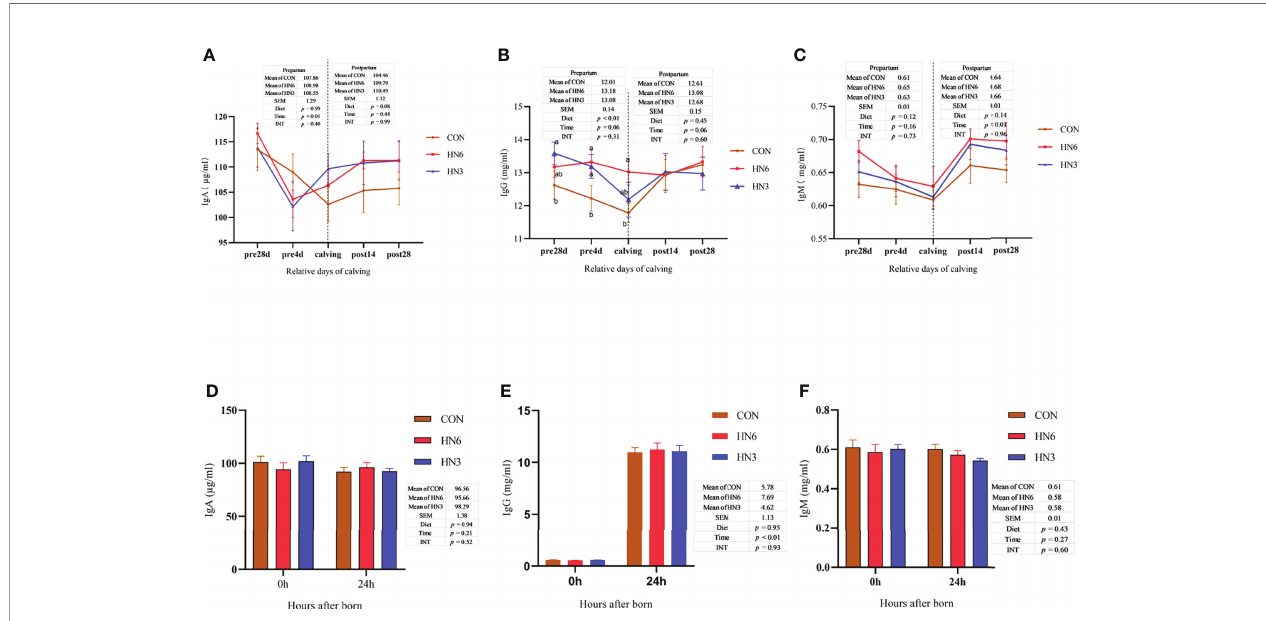
FIGURE 3 | Blood immunoglobulin in maternal and neonatal cows. CON: control treatment (saturated fatty acid source), n = 12. HN3: extruded fl axseed treatment (n-3 PUFA source), n = 12. HN6: extruded soybean treatment (n-6 PUFA source), n = 13. SEM, standard error of the means; Diet, diet treatment effect; Time, the calving time effect; INT, the interaction effect between diet effect and time effect. IgA, immunoglobulin A; IgG, immunoglobulin G; IgM, immunoglobulin M. (A – C) The blood immunoglobulin in maternal cows; (D – F) the blood immunoglobulin in neonatal calves. Values in the same sampling time point between treatments denoted by different superscript lowercase letters indicate signi fi cant differences ( p < 0.05), whereas those denoted by the same letters or no letters are not signi fi cantly different ( p > 0.05).